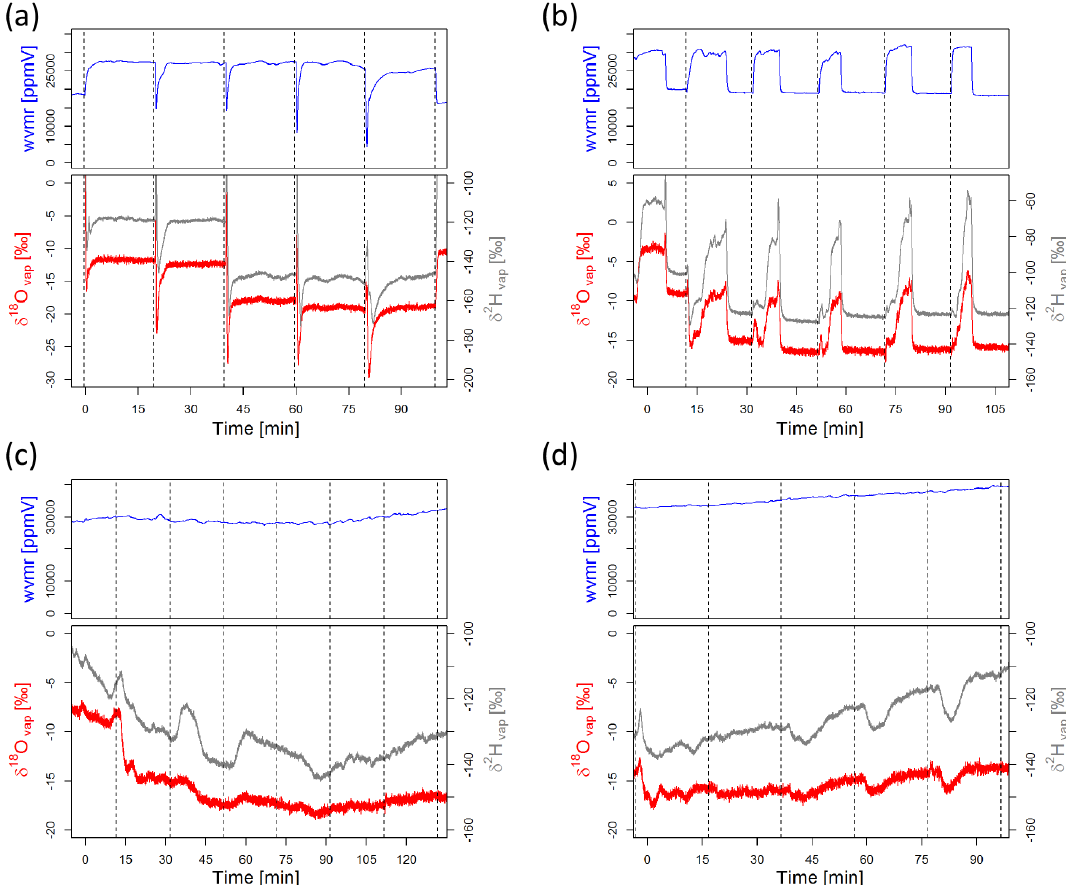
Figure 5. Measurement cycle of an in situ system switching through different probes. Shown are water vapor concentration (wvmr – water vapor mixing ratio – in ppmV) and the raw vapor values for δ 2 H and δ 18 O in per mil. Each probe was measured for 15min, and then the manifold was switched to the next probe (indicated by dashed vertical lines). The different panels show (a) a clean measurement with a stable plateau for the three variables; (b) a measurement where small amounts of condensation were present in the system but then removed during the measurement phase, resulting in a stable plateau towards the end of each cycle; and ( c and d ) two examples of erroneous measurements, where condensation (very high ppm values) does not allow the laser analyzer to reach a stable